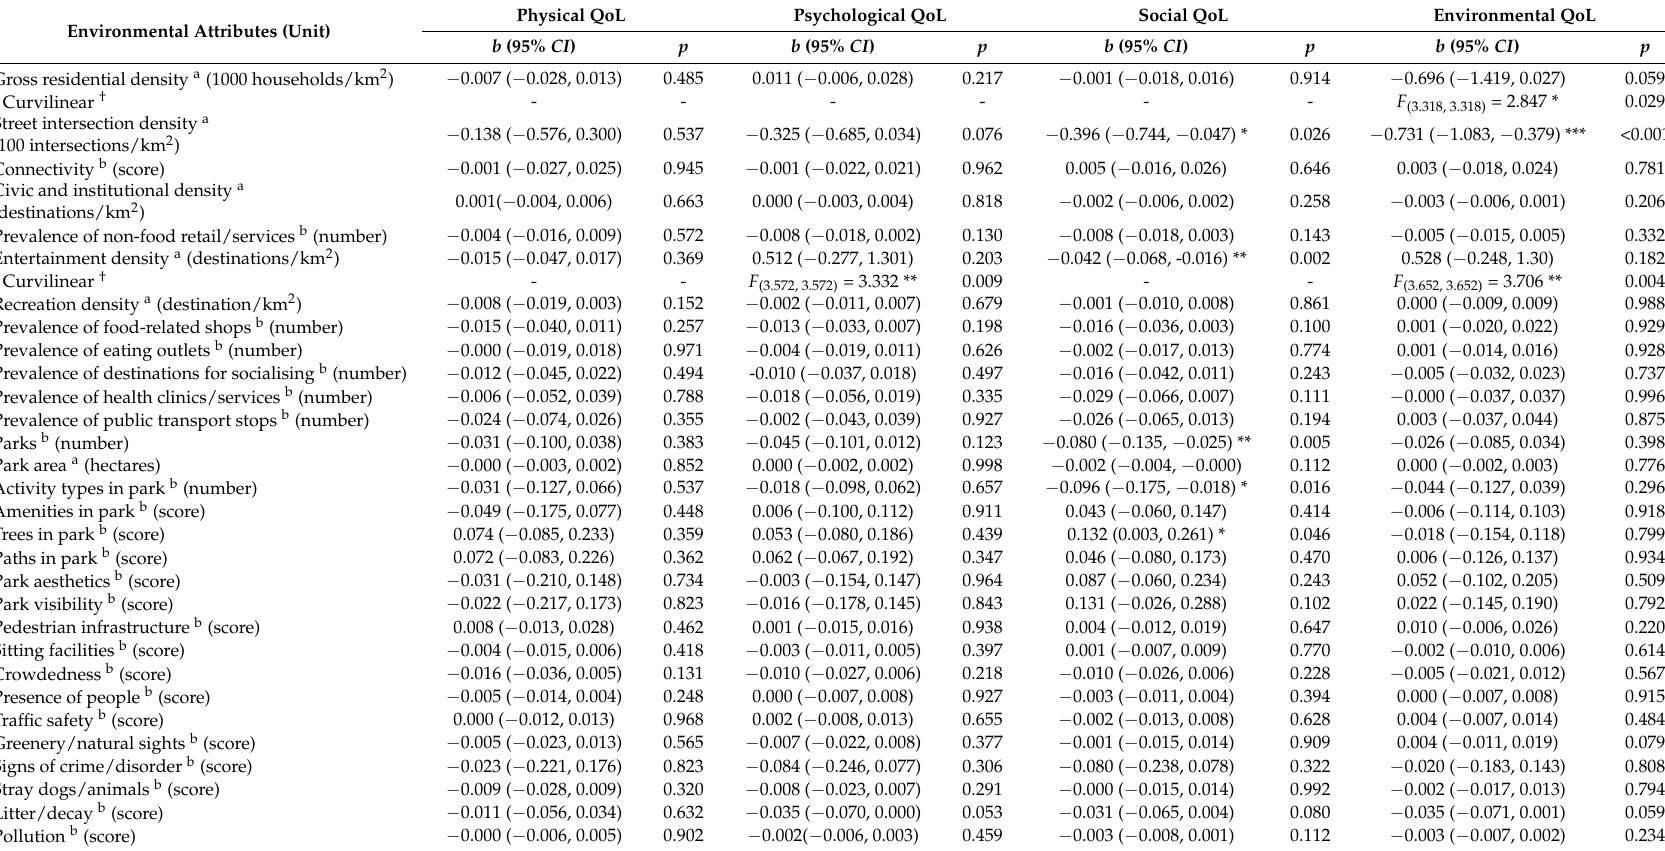
Table 2. Associations of single neighbourhood physical environmental attributes with quality of life (QoL)